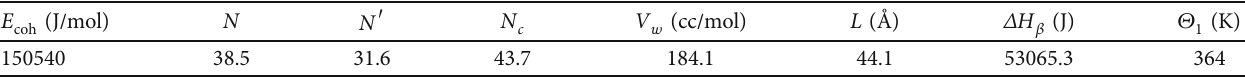
Table 4: GIM input parameters for the CMDB propellant.